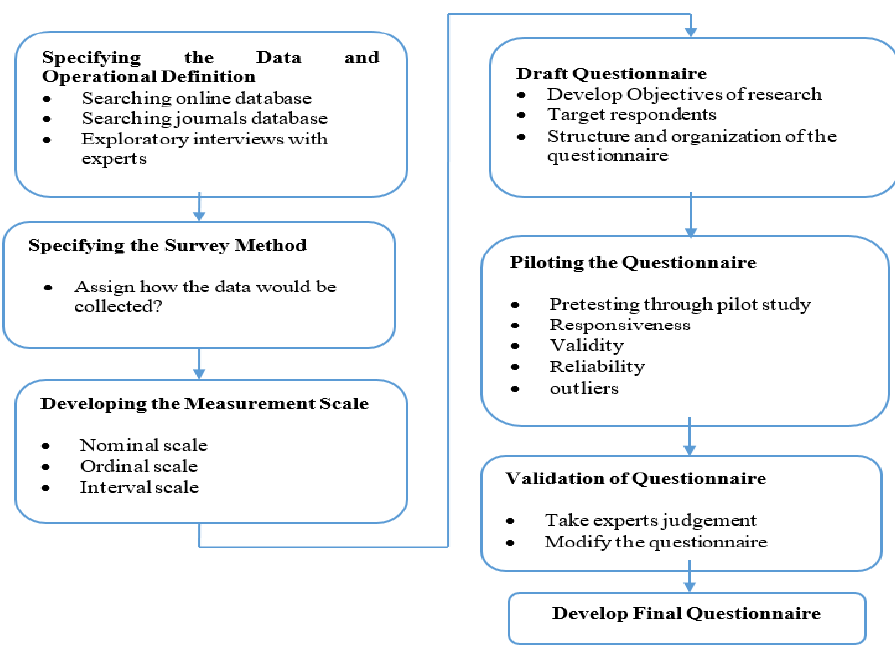
Figure 2. Stages of the questionnaire’s design.